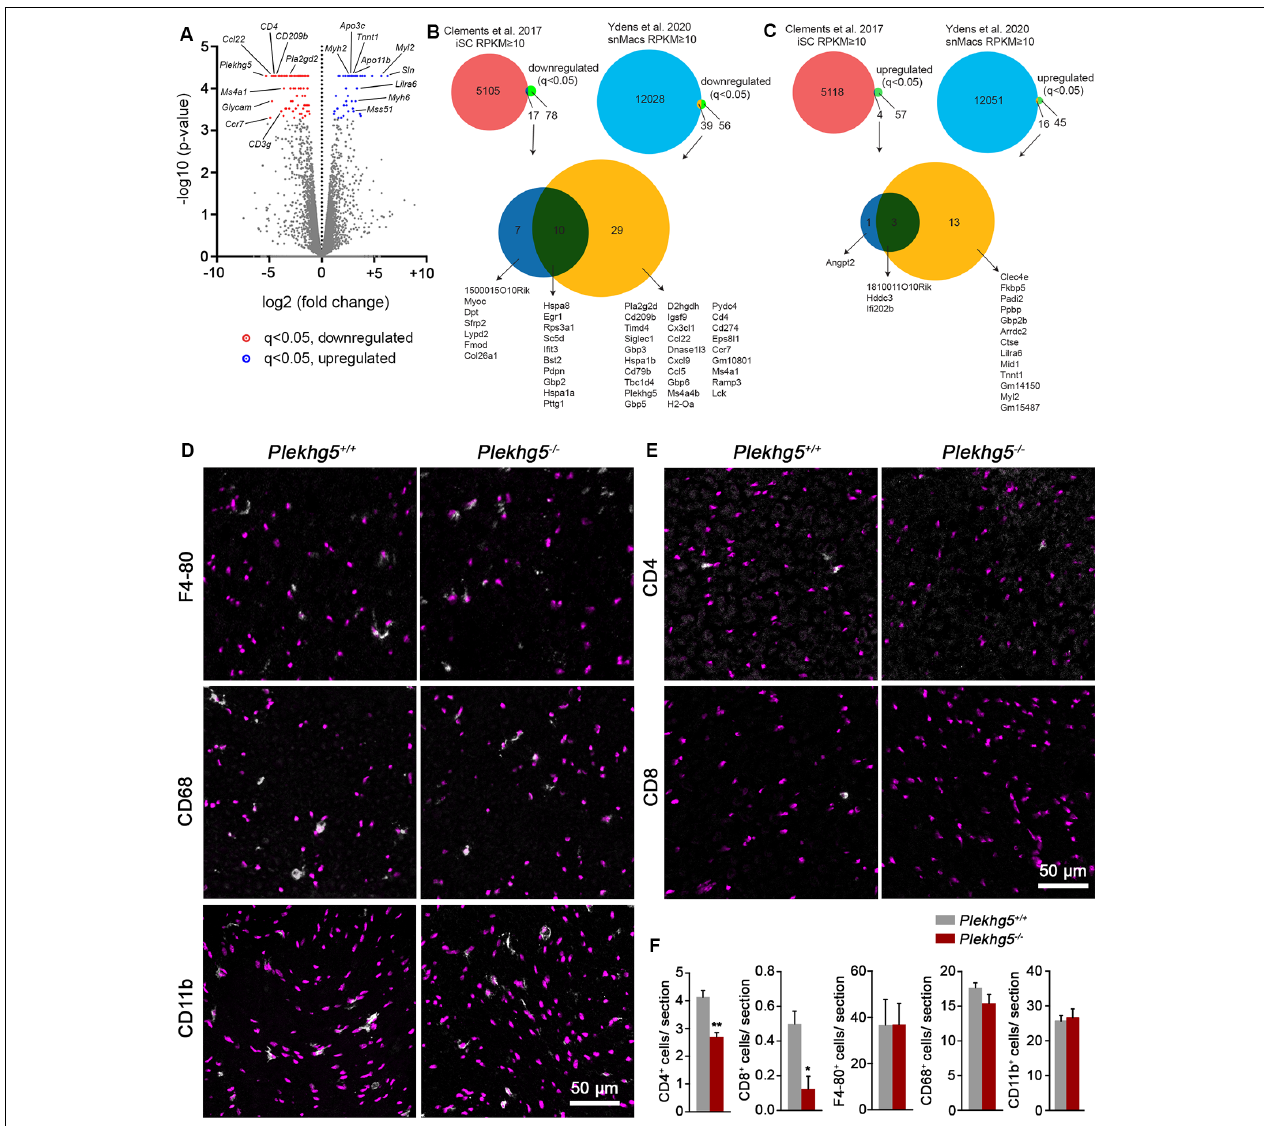
FIGURE 4 | Lack of Plekhg5 results in a reduced immune response within the sciatic nerve. (A) Volcano plot showing the significance of transcript change [ − log 10 ( p -value)] vs. the magnitude of change [log 2 (fold change)]. Downregulated transcripts with q < 0.05 are marked in red, upregulated transcripts with q < 0.05 are marked in blue. Data points for transcripts with log2FC < − 10 or > 10 (all of which were not significantly altered) were omitted for visualization purposes. Three animals per genotype were analyzed. (B,C) Venn diagrams depicting the number of downregulated (B) or upregulated (C) genes enriched in iSCs and snMac (upper panel). Overlap between the downregulated (B) or upregulated (C) transcripts found in iSCs and/or snMacs (lower panel). iSCs—isolated Schwann cells. snMacs—sciatic nerve Macrophages. (D,E) Immunohistochemical stainings of sciatic nerve cross-sections for the macrophage markers F4–80, CD-68, and CD11b and the T-lymphocyte markers CD4 and CD8. (F) For each marker, at least eight sections per animal were analyzed. Three animals per genotype ( n = 3, unpaired, two-tailed t -test). * p < 0.05; ** p <